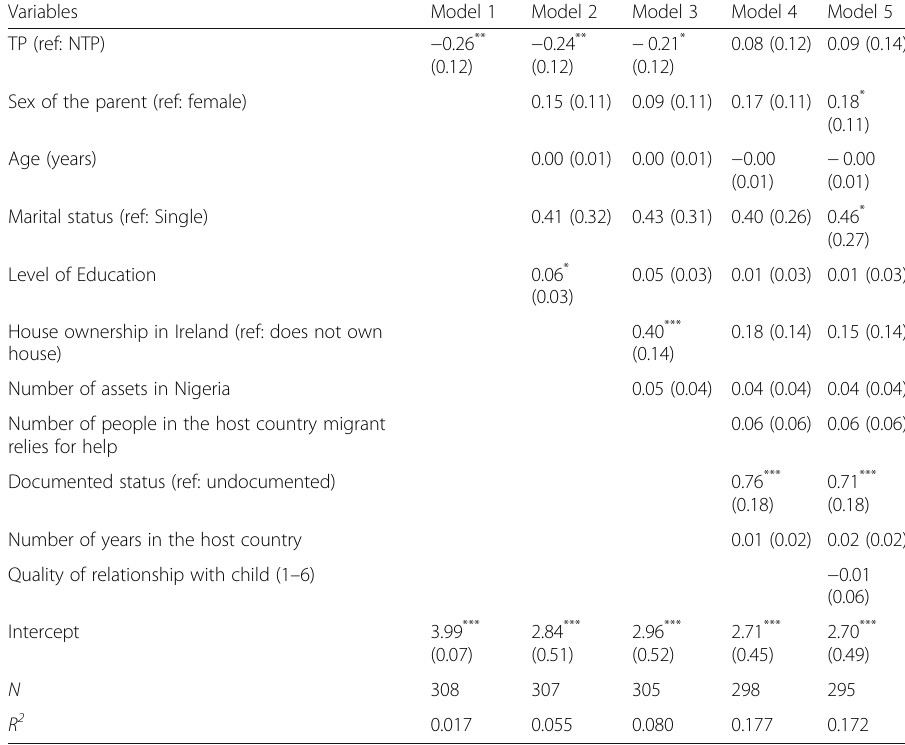
Table 5 Ordinary Least Squares regressions predicting satisfaction with life, Ireland Variables Model 1 Model 2 Model 3 Model 4 Model